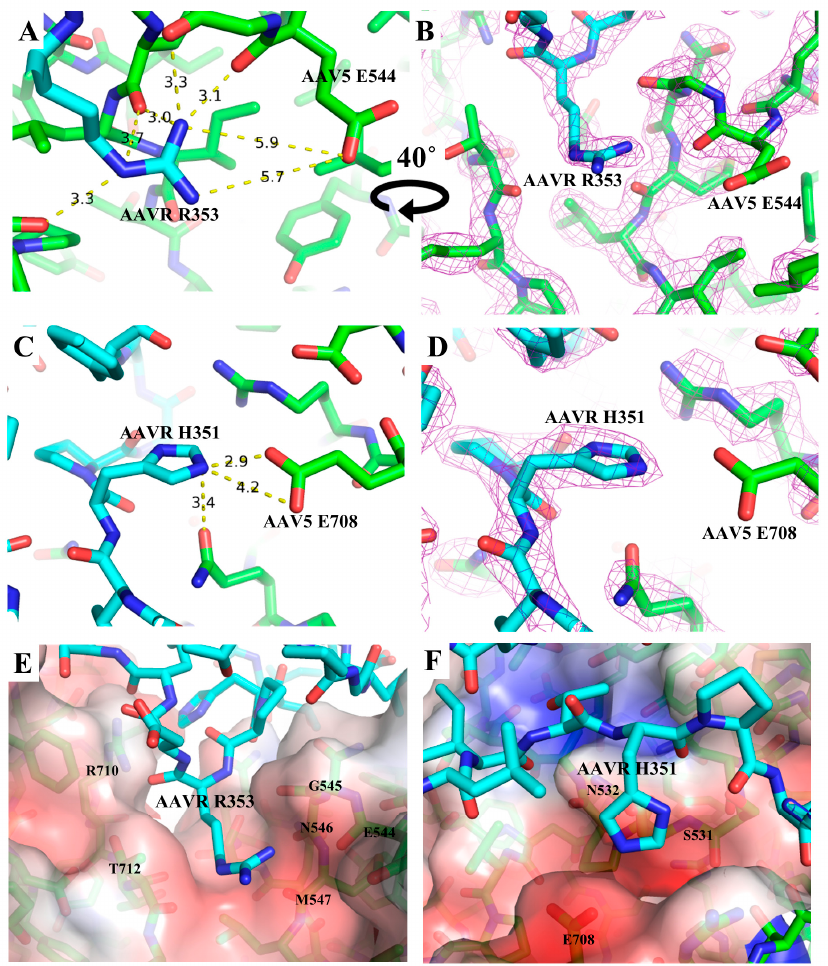
Figure 2. AAV5-PKD1 interactions with PKD1 carbon atoms in cyan and AAV5 carbon atoms in green. The EM map is shown at the 2 σ -level as violet mesh on panels B and D. ( A , B ) PKD1 R353 is shown with distances (Å) to neighboring atoms of AAV5. ( C , D ) PKD1 H351 is shown, highlighting potential hydrogen bonding interactions with AAV5. ( E , F ) The solvent accessible surface of AAV5 is colored according its electric potential as calculated using the APBS adaptive Poisson-Boltzmann solver [33]. Electro-negative surfaces (red), formed by charged side chains and polar backbone carbonyls, form pockets on AAV5 into which AAV5 R353 (E) and H351 (F) are accommodated.